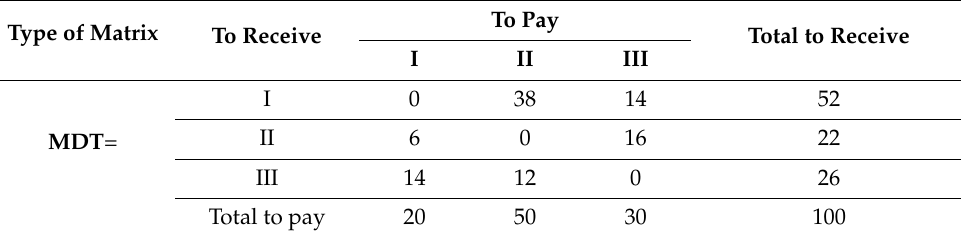
Table 4. The Matrix of Debit Turnovers MDT in a matrix form.